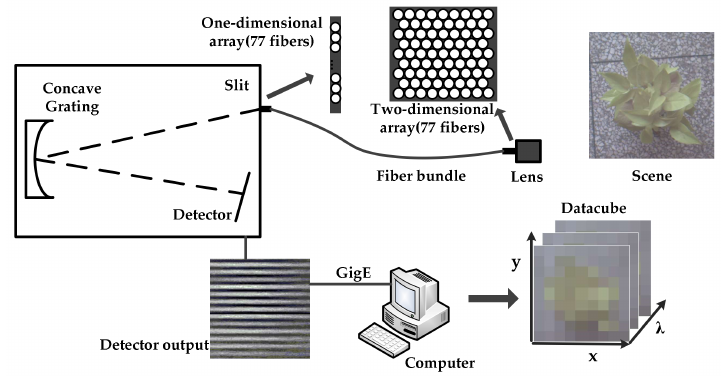
Figure 2. Schematic of the snapshot imaging system. A fiber array is used as the field diaphragm to transform a scene from two- to